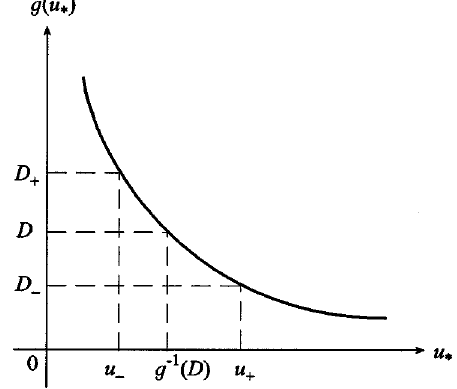
Fig. 2. General shape of the trade-off curve and illustration of the duality